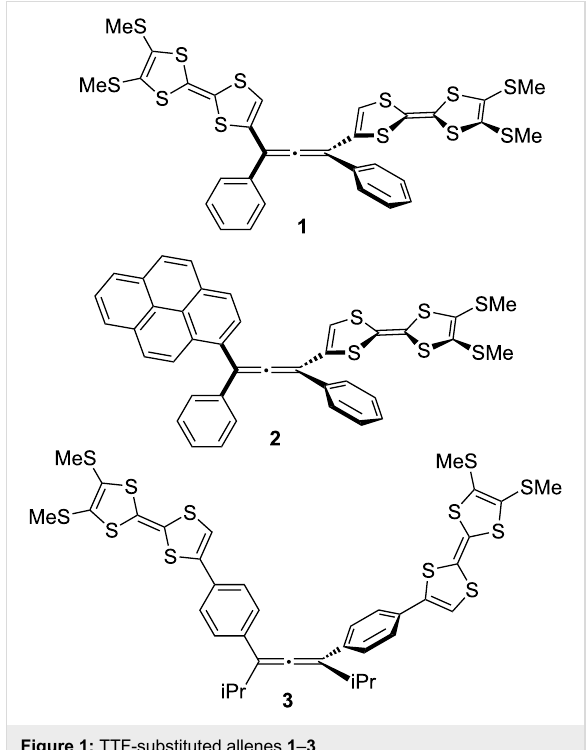
Figure 1: TTF-substituted allenes 1 – 3 .